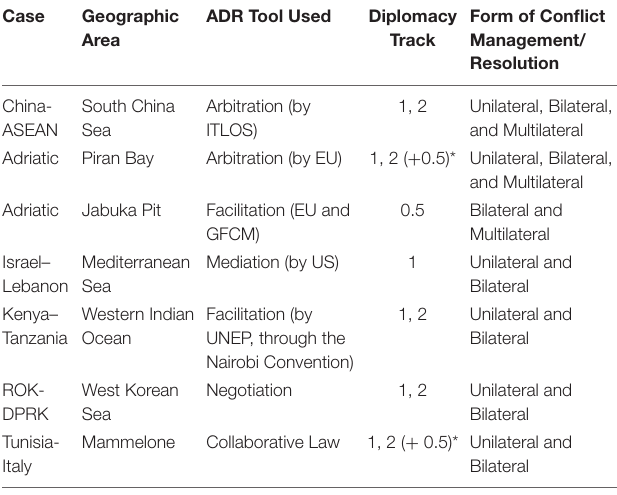
TABLE 2 | ADR tools and track/level of diplomacy in six case studies. Case Geographic ADR Tool Area